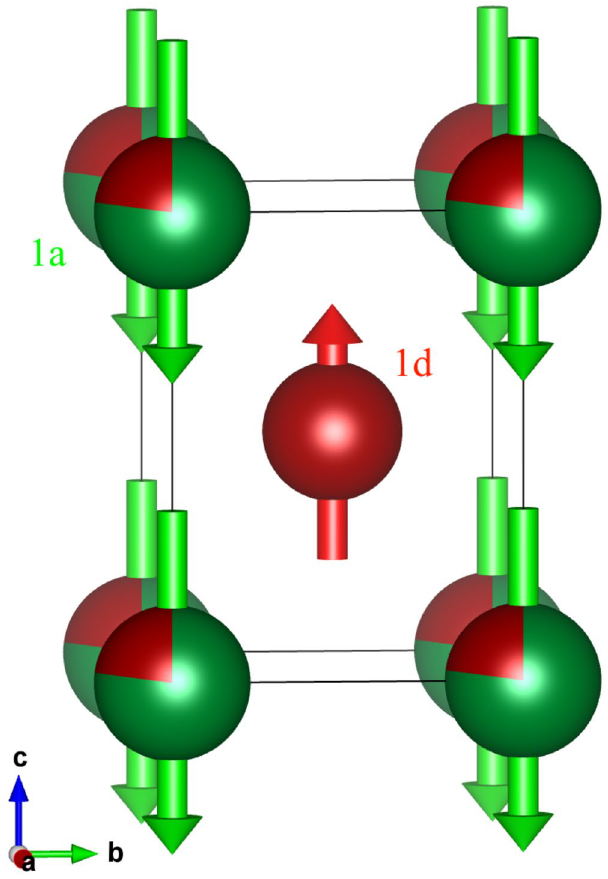
Figure 7. Magnetic structure for Mn x Ga deduced from our fits to the neutron diffraction data. The Mn moments on the manganese that partially replaces gallium on the 1 a site are slightly larger and antiparallel to those on Mn that occupies the 1 d